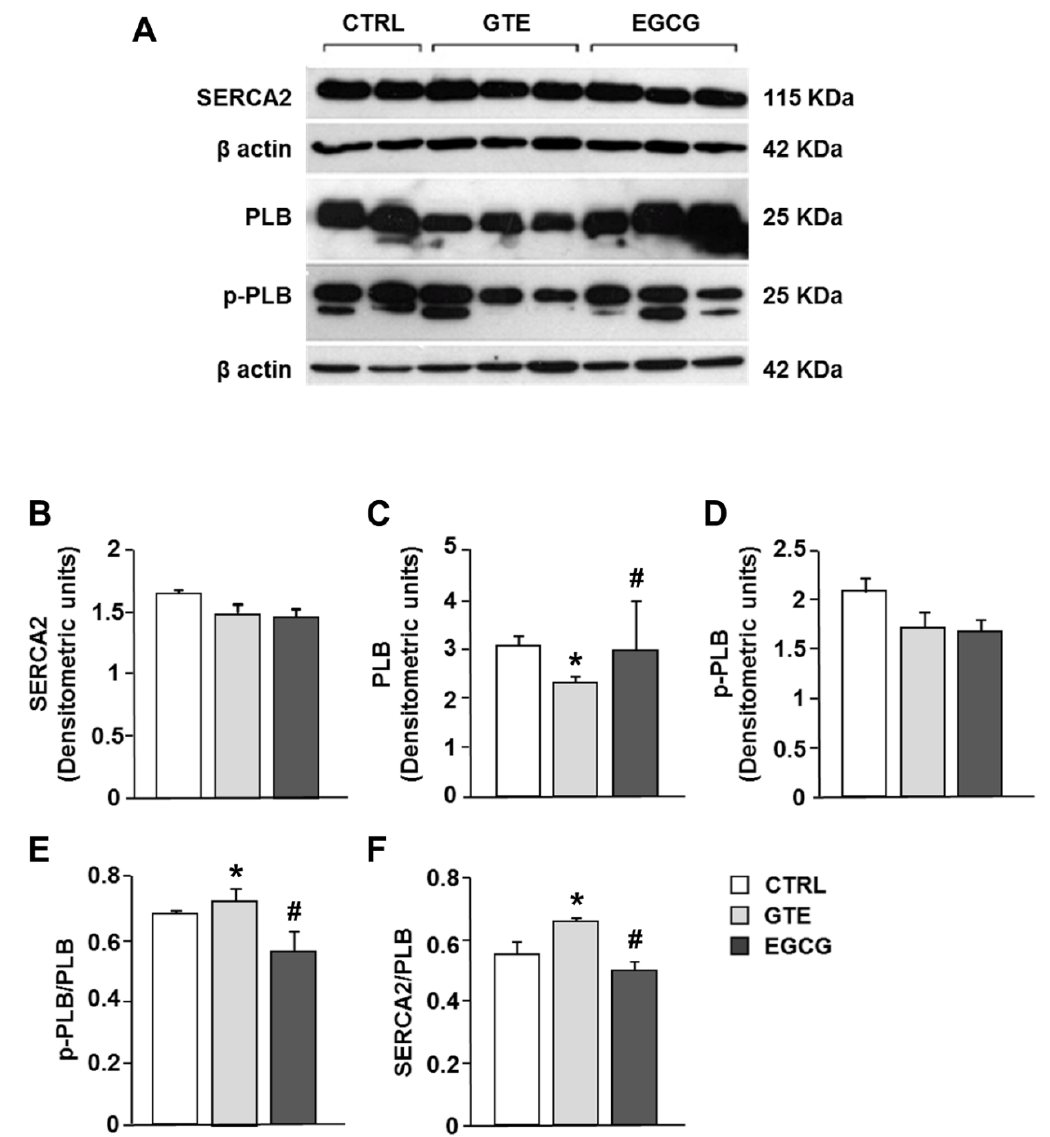
Figure 7. Sarcoplasmic reticulum calcium-ATPase (SERCA2), phospholamban (PLB), and phosphorylated phospholamban (p-PLB) protein expression changes in LV heart tissue of CTRL ( n = 2), GTE- ( n = 3), and EGCG-supplemented rats ( n = 3). ( A ) Typical electrophoretic separation and immunodetection of SERCA2, PLB, p-PLB, in the LV heart tissue of control and supplemented rats. The expression levels of SERCA2 ( B ), PLB ( C ), and p-PLB ( D ) were measured by densitometric analysis and normalized to β-actin. Densitometry was performed by the Quantity One analysis software (Bio-Rad). p-PLB/PLB ( E ) and SERCA2/PLB ( F ) ratios. Histograms show the mean ± SEM. * p < 0.05 indicates significant differences vs. CTRL; # p < 0.05 indicates significant differences between GTE and EGCG.